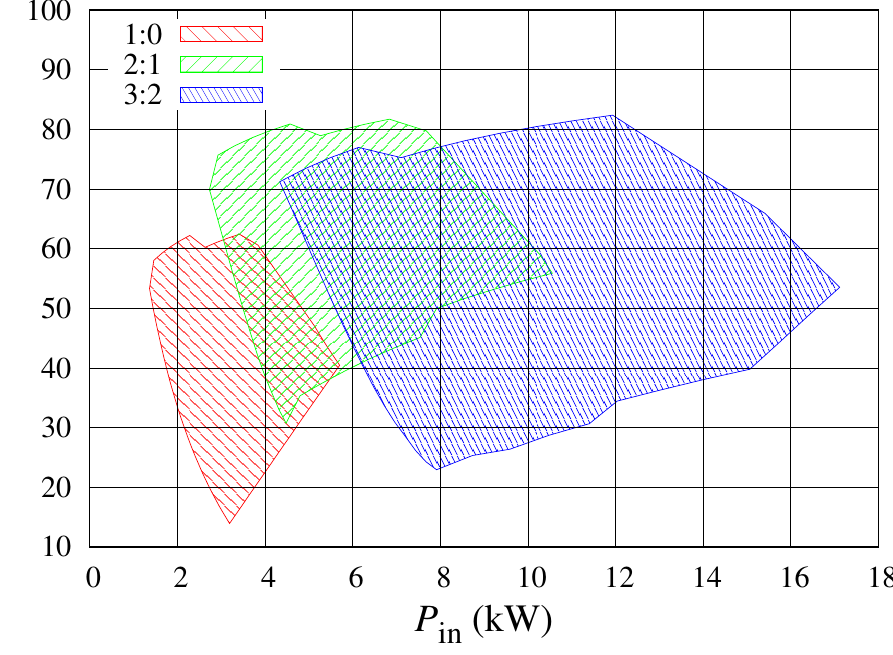
Figure 5. R for different BWRO configurations using sample 20 (Table 1) as C f .